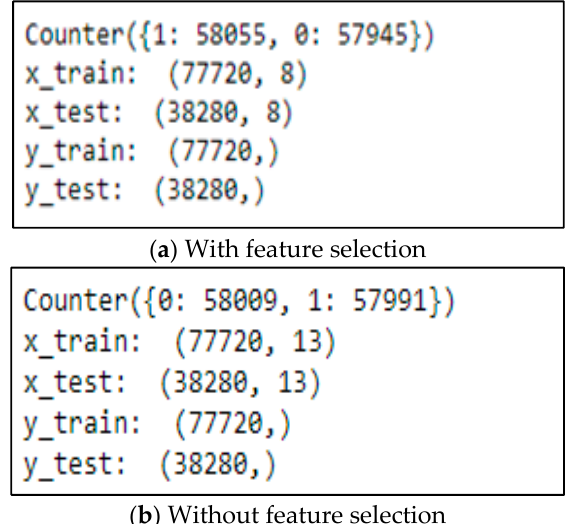
Figure 8. Dataset balanced using Make_Classification function.